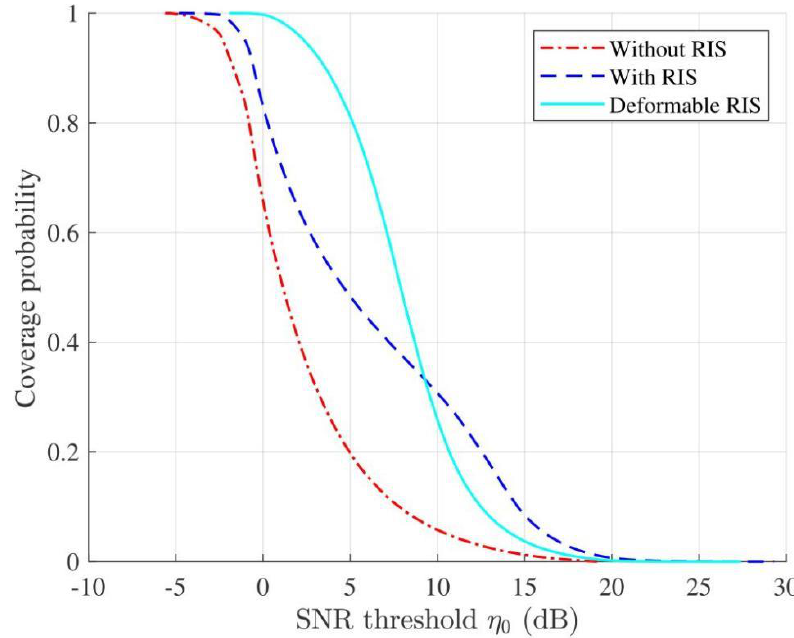
Figure 8. Coverage probability in different